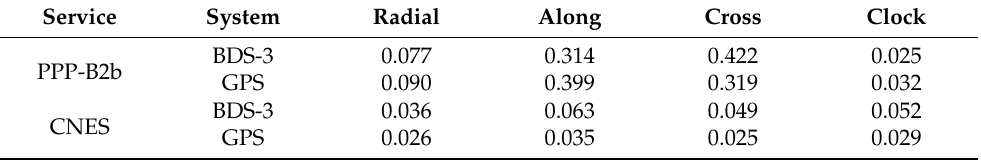
Table 1. The average STD and RMS of BDS-3/GPS PPP-B2b orbits and clock errors (unit: m). Service System Radial Along Cross